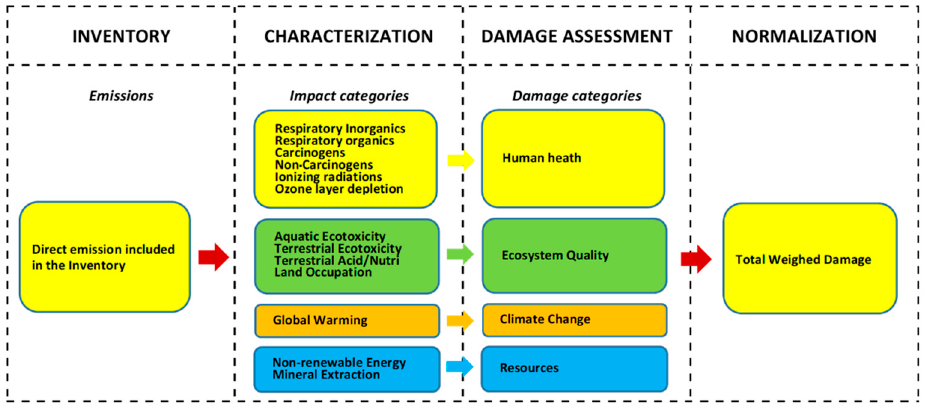
Figure 1. Structure of an LCIA procedure (adapted from [29]).